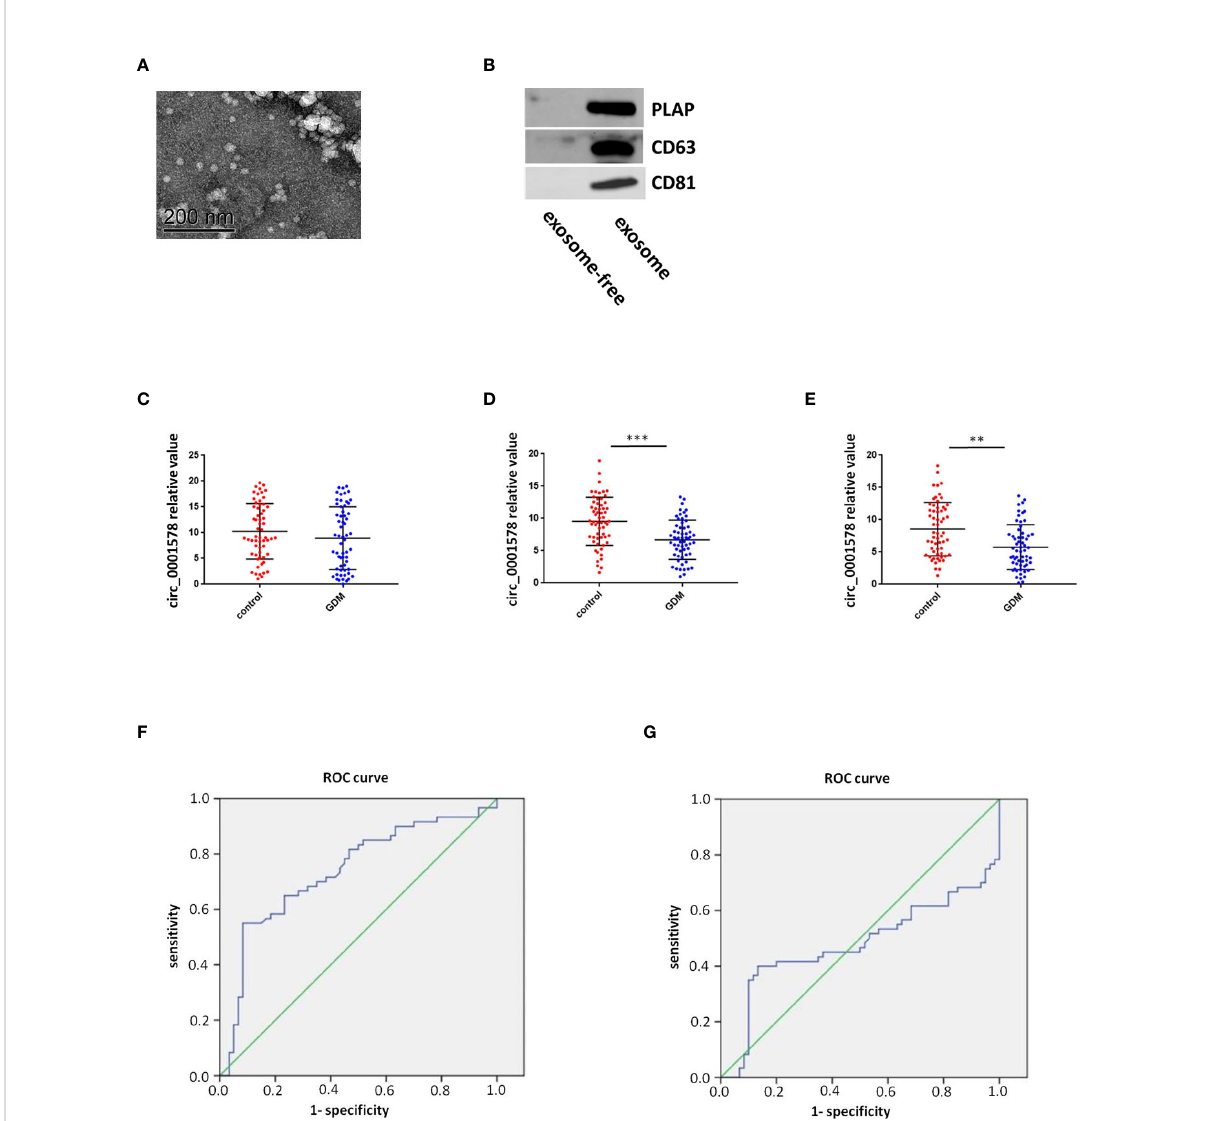
FIGURE 2 Diagnostic value of placenta-derived exosome circ_0001578 in GDM. (A) Identi fi cation of placenta-derived exosomes by TEM and Western blotting. (B) Identi fi cation of placenta-derived exosomes by Western blotting. (C) Placenta-derived exosome circ_0001578 expression in GDM and control groups in the fi rst trimester (8.93 vs. 10.00, P = 0.21). (D) Placenta-derived exosome circ_0001578 expression in GDM and control groups in the second trimester (6.19 vs. 9.56, P < 0.05). (E) ROC curve analyses of the diagnostic value of placenta-derived exosomecirc_0001578 in the second trimester. (F) Placenta-derived exosome circ_0001578 expression in GDM and control groups in the third trimester (5.75 vs. 8.61, P < 0.05). (G) ROC curve analysis of placenta-derived exosome circ_0001578 in the third